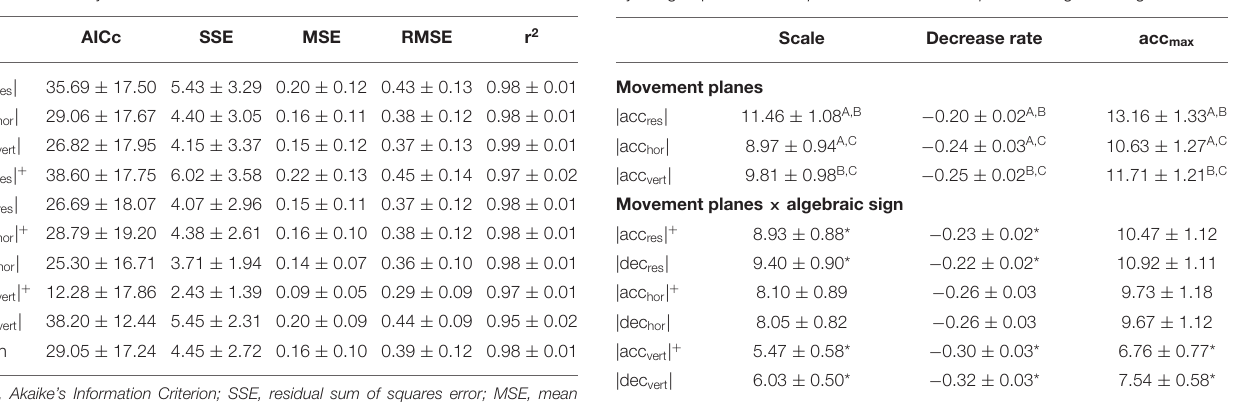
TABLE 2 | Parameters characterizing the exponential curve shape of the relationship between peak median accelerations and time durations (t dur ) ordered by the groups movement planes and movement planes